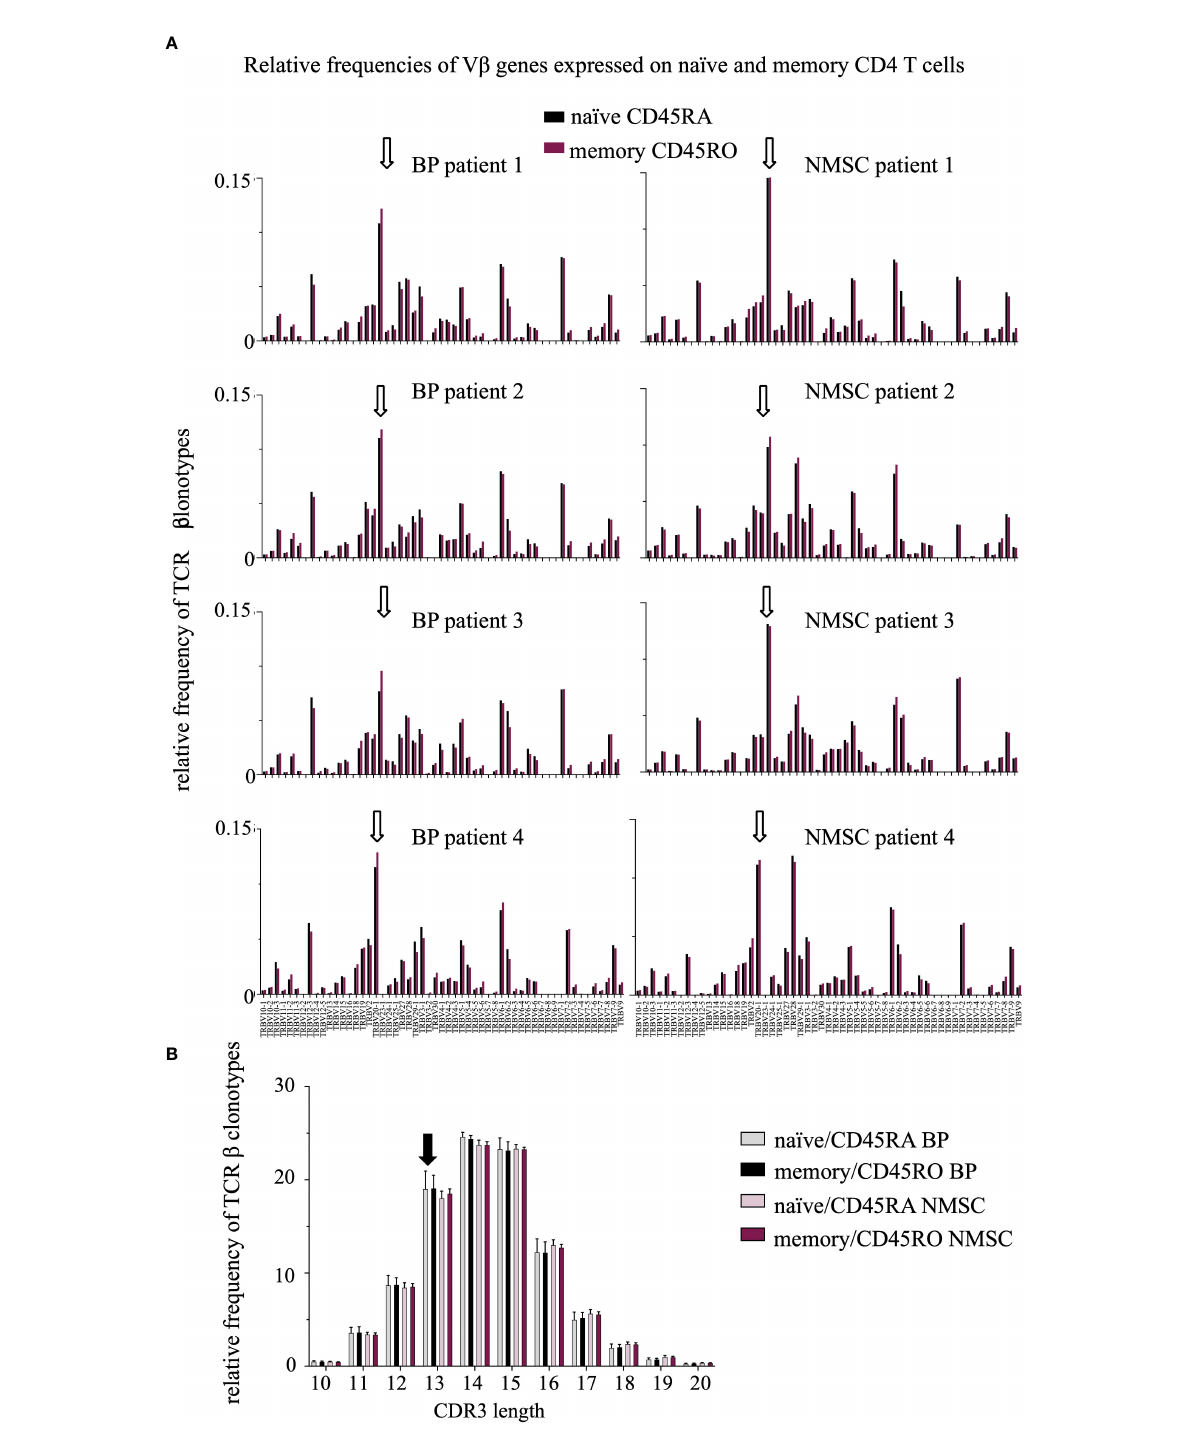
FIGURE 4 A trend toward a reduced length of the CDR3 region in BP patients was observed but no difference in the V gene usage between the patient groups. (A) Relative frequencies of V b genes were compared between the CD45RO (red bars) and CD45RA (black bars) population in BP patients (1-4, left) and NMSC patients (1-4, right). White arrows indicate the high expression of the V b genes TRB20-1 in all samples. The high usage of TRBV20-1 has been described previously and was associated with aging (35, 36). (B) Relative length distribution of the CDR3 regions of CD45RO and CD45RA TCR b clonotypes were compared between BP and NMSC patients (Data are means ± SD). The black arrow indicates the increased frequency of TCR b clonotypes with a CDR3 length of 13 amino acids in BP patients (black, gray bars) compared to NMSC patients (bright and dark red